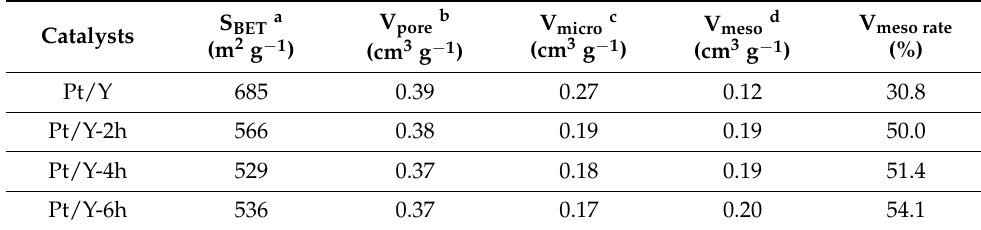
Table 1. Textural properties of the Pt/Y zeolites.